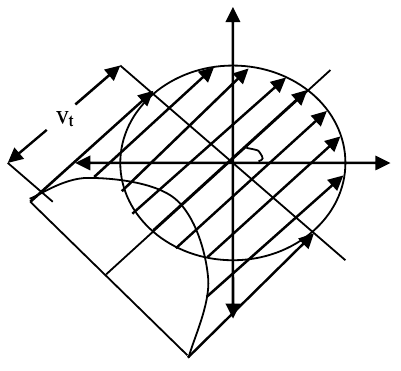
Figure 12. Distributed computing model of link break arrival time.